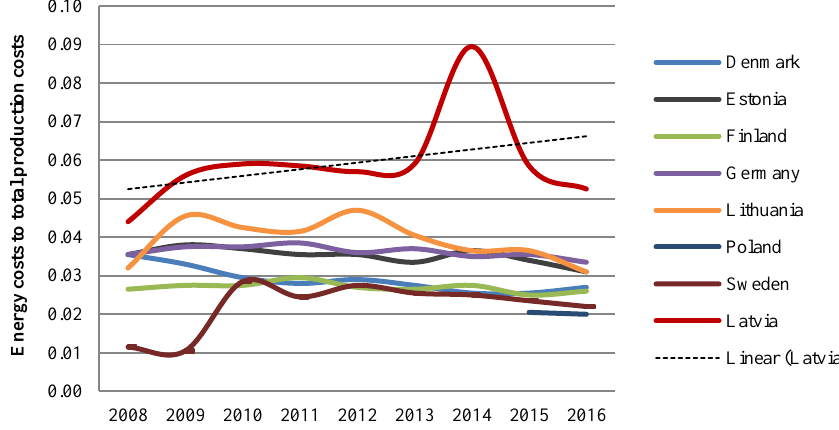
Fig. 6 . Energy costs to total production costs in food and beverages producing industries (Latvia and Baltic Sea region countries). However, the share of energy costs in the overall production costs in Latvia is reported at a higher level than other Baltic sea countries. Data analysis reveals the same untypical results for the year 2014, which is likely to be a data error and should be excluded from further sector analysis.